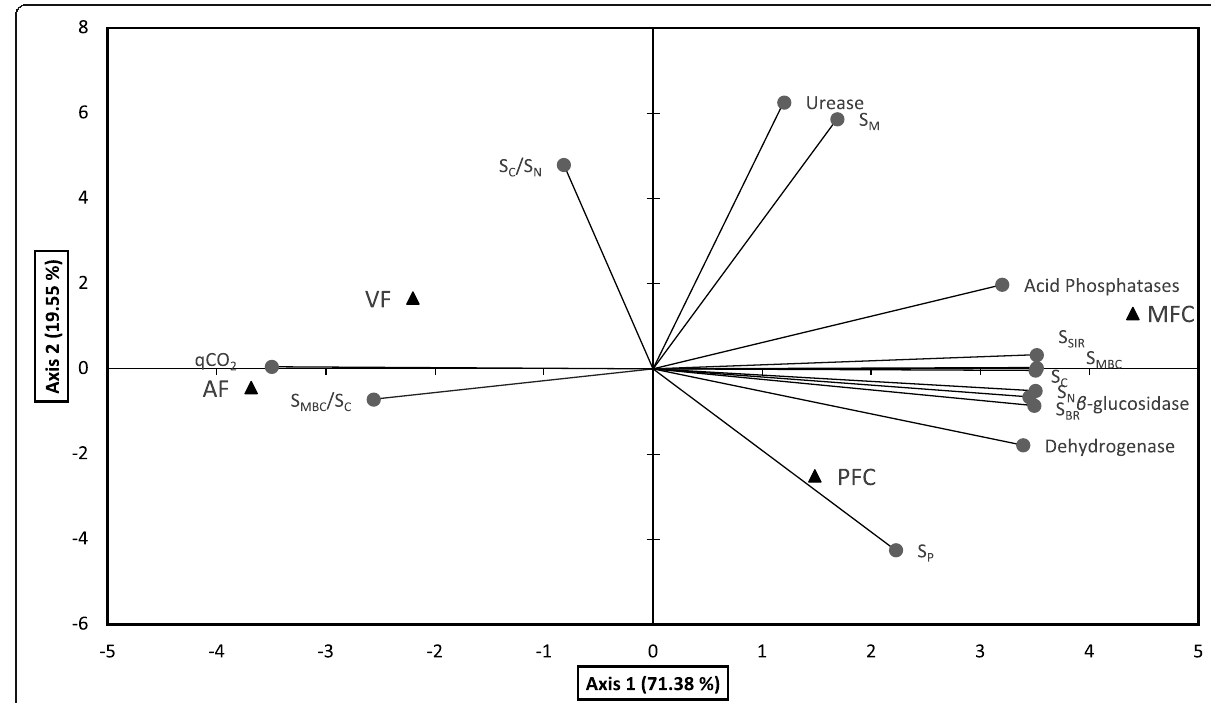
Fig. 4 PCA-ordination biplot (PC 1 vs PC 2) of soil physicochemical, microbial parameters, and enzyme activities of different land uses at a semiarid region of Delhi. Note: S C soil carbon, S N soil nitrogen, S P soil phosphorus, S M soil moisture, S MBC soil microbial biomass carbon, S BR soil basal respiration, S SIR soil substrate-induced respiration, S MBC /S C soil microbial biomass carbon to soil carbon ratio, qCO 2 metabolic quotient, S C /S N soil carbon to soil nitrogen ratio, MFC mixed forest cover, PFC P. juliflora- dominated forest cover, AF agriculture field, VF vegetable